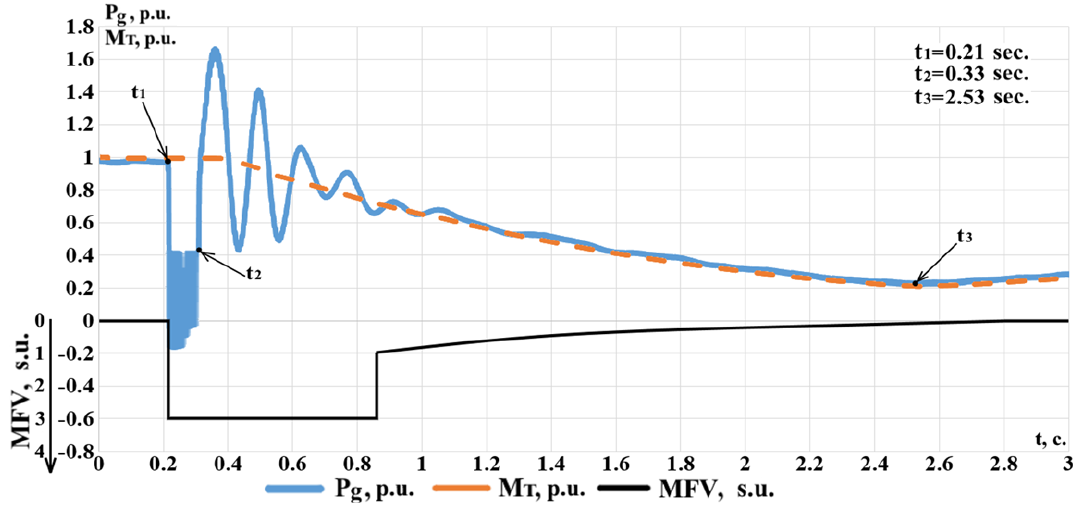
Figure 15. Generator G 2 active power and turbine torque for a case of FV ( A i = 3 pu). The value of Ai = 3.5 pu. allows for a realization of the process of FV at 10.5% faster than at A i = 3 pu. and only at 2.8% slower than at A i = 4 pu. The increase in the FV speed for a case of A i = 4 pu. is not expedient considering the increased influence on the control